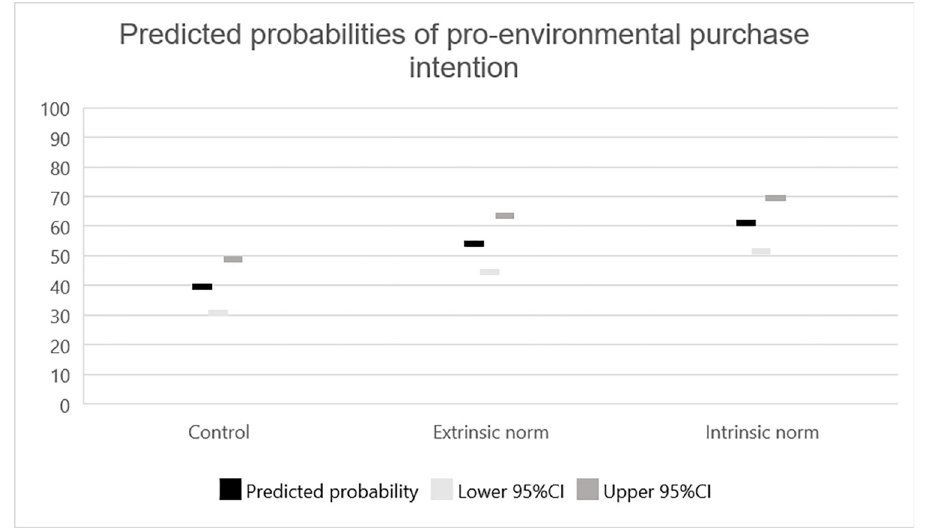
Fig 1. Predicted probabilities with 95% confidence intervals for conformity to specific norm (intention to purchase eco-labeled chocolate bar).